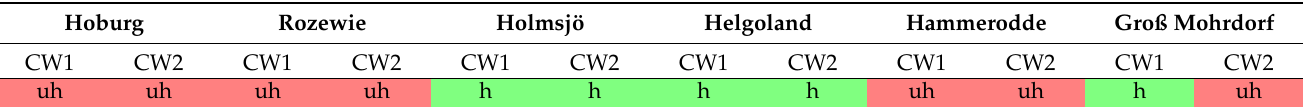
Table 3. Night-time signals used for the position and time estimation in green with the “h” flag. Signals in red with the “uh” flag were not used.